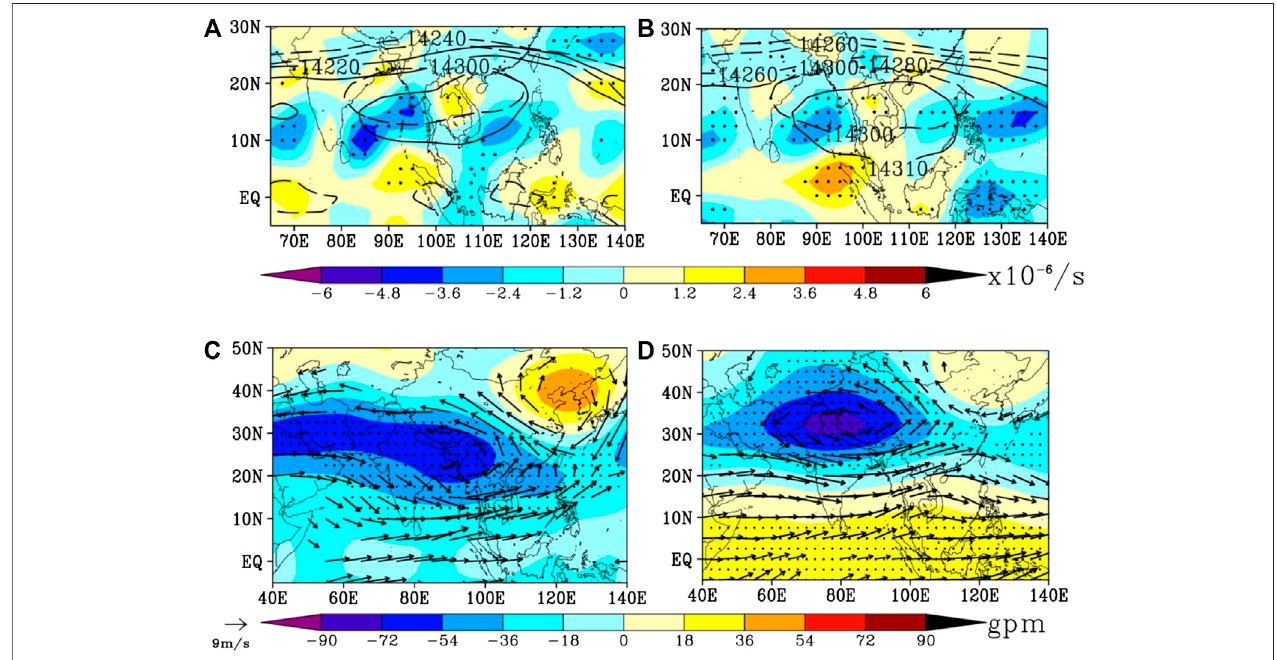
FIGURE 8 | Composite differences of (upper) the divergence anomaly (shaded; unit: s-1) and (bottom) geopotential height (shaded; unit: gpm) and horizontal wind (vector; unit: m/s) anomaly at 150 hPa in May between positive and negative years of PC2 for the period of (left) 1958 – 1979 and (right) 1980 – 2018. The positive (negative) years of PC1 are higher (lower) than 0.5 ( − 0.5). The black contour of (A) and (B) indicates the composites of150 hPa geopotential height (contour; unit: m) for PC2 higher than 0.5 (solid line) or lower than − 0.5 (dashed line). The stippling and black vectors denote values exceeding the 90% con fi dence